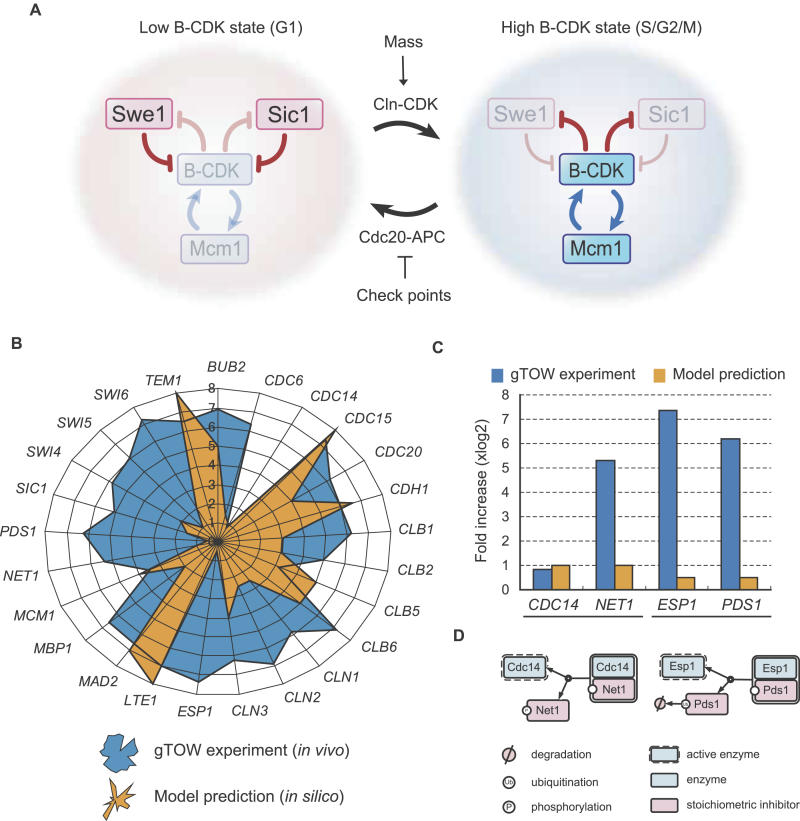
System Level Analysis of the Copy Number in the gTOW Experiment(A) Genes with low copy numbers in the gTOW experiment construct a subsystem that contains three positive feedback loops which regulate B-type cyclin activity [23,29]. This subsystem potentially makes two stable steady-states of B-type cyclin activity. Those states correspond to G1 phase and G2-S-M phase, respectively, which are altered by Cln-CDK and Cdc20-APC activity in the normal cell cycle [29].(B) Comparison of the upper limit gene copy numbers obtained in the gTOW experiment and a computational cell cycle model. The upper limit gene copy numbers in vivo are considered as the plasmid copy numbers plus 1 in the gTOW experiment. Maximum fold variable change in xlog(2) toward the outside of the circle up to 256-fold is shown. The data used in the graphs are listed in Table S4.(C) Upper limit copy numbers of stoichiometric partners in predictions of the computer model and gTOW experiment. The data used in the graph are the same as in Figure 6B.(D) Simplified diagrams showing stoichiometric partners, where the enzymes are regulated by their inhibitors by 1:1 stoichiometric molecular interaction. The diagrams are shown as implemented in the computer model by Chen et al. [19].